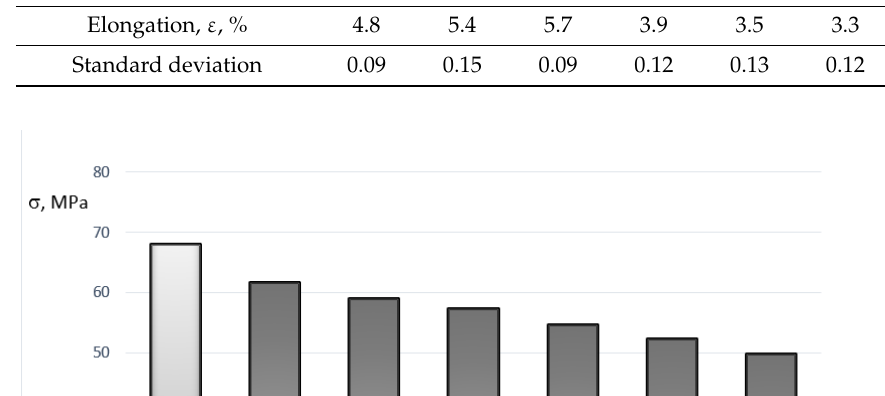
Table 6. Strength and elongation at break depending on the content of the Crusil M20 filler. Contents, % wt.